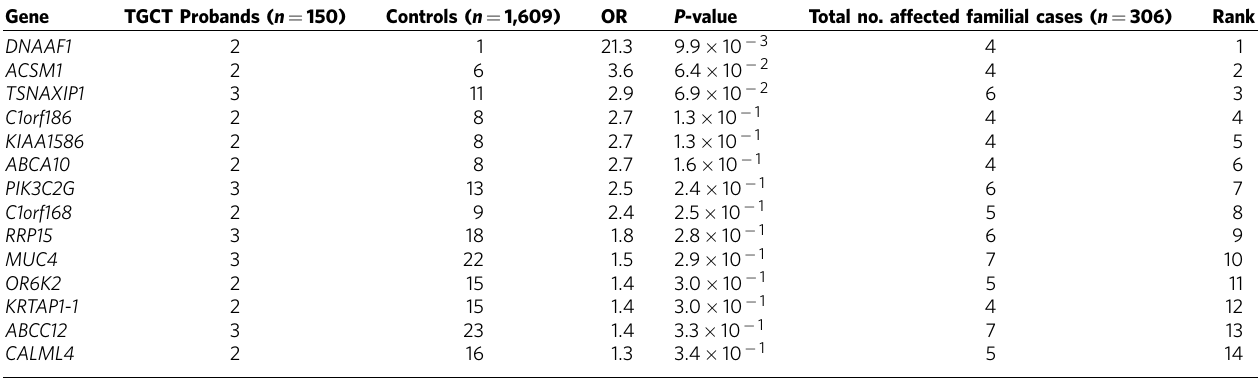
Table 1 | Genes with rare MAF o 1% disruptive mutations segregating in two or more familial TGCT pedigrees. Gene TGCT Probands ( n ¼ 150)